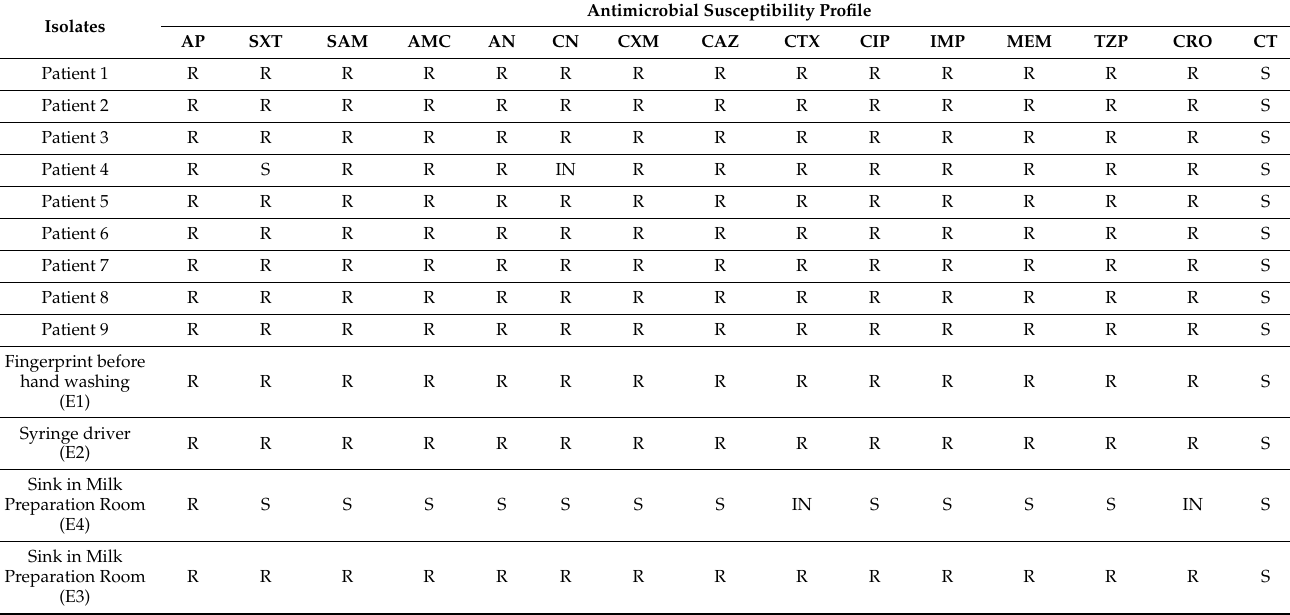
Table 3. Antibiograms of Acinetobacter baumannii